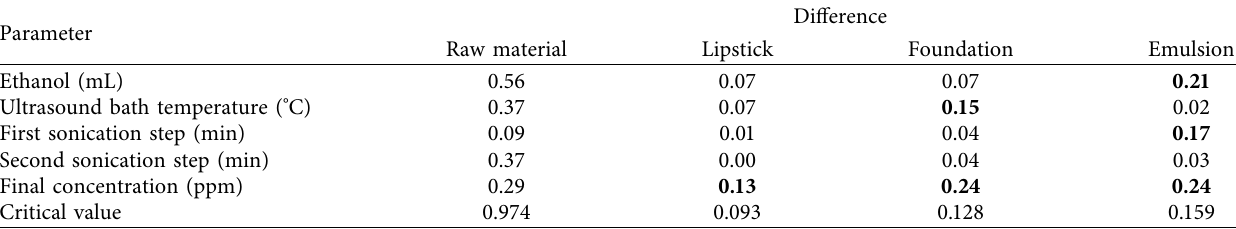
Table 1: Difference values for the variables studied under the Youden–Steiner model.